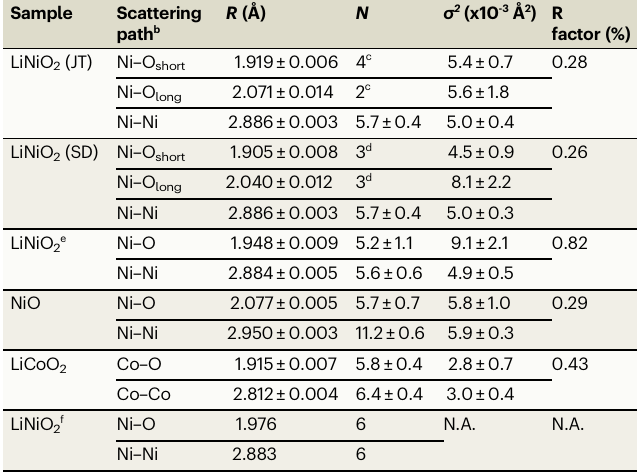
Table 1 | Structural parameters of LiNiO 2 , LiCoO 2 , and NiO, obtained from EXAFS fi tting a Sample Scattering path